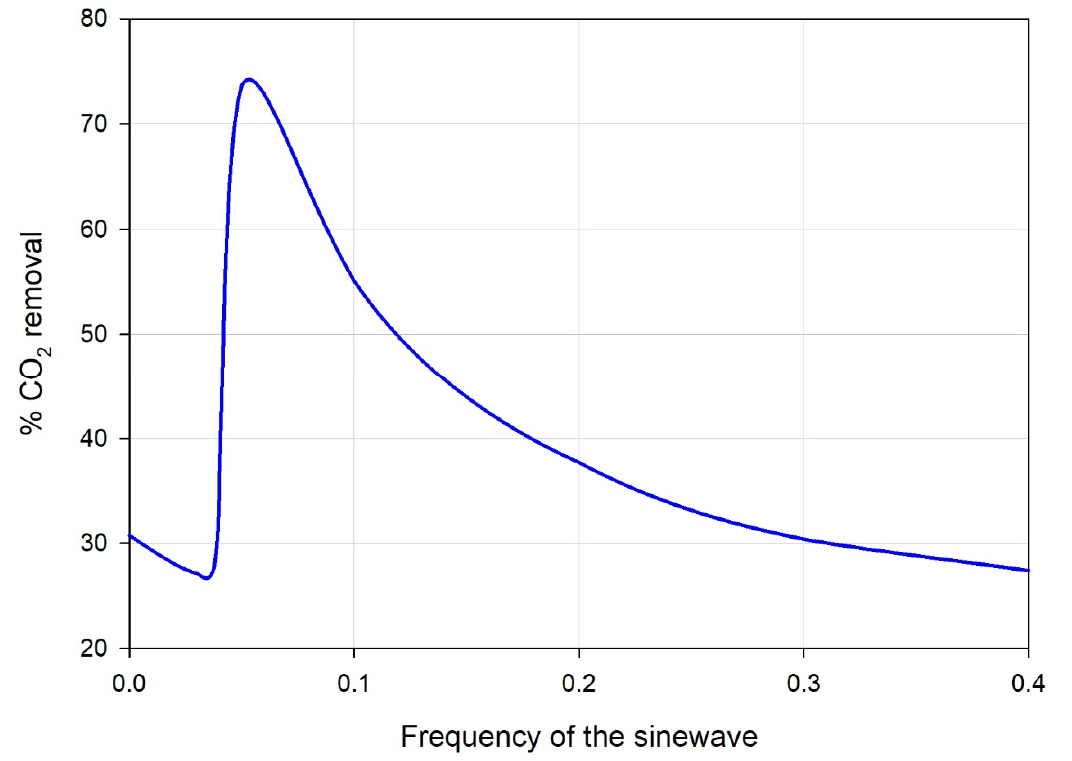
Figure 4. Effect of gas feed oscillation frequency on the CO 2 concentration profile versus membrane dimensionless length of the gas flow on the shell side. Gas feed rate 500 mL/min, liquid feed rate 10 mL/min.